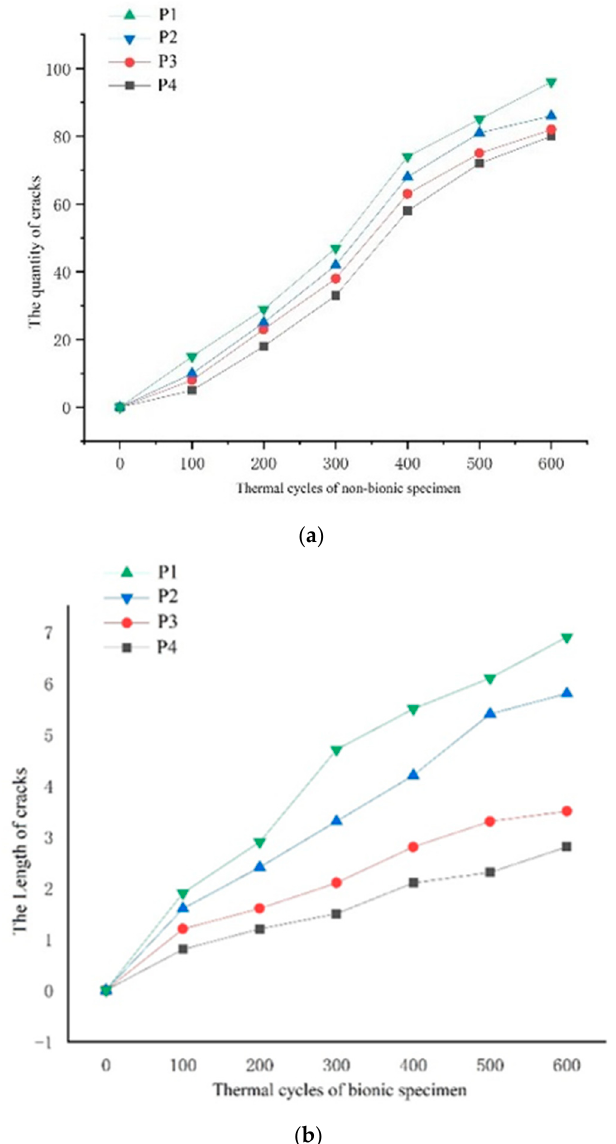
Figure 16. Statistical curves of the length and number of thermal fatigue cracks of biomimetic units arranged in different ways from 0 to 600 times. ( a ) The quantity of cracks, ( b )The length of cracks